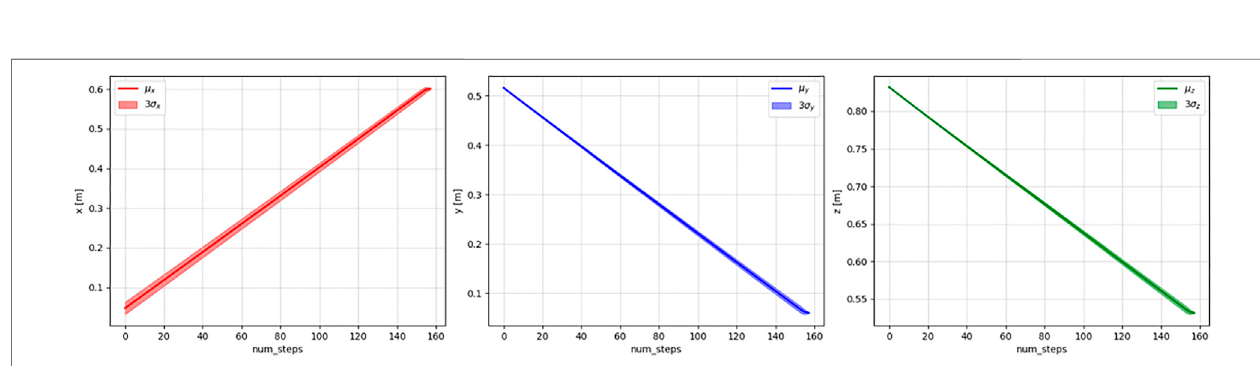
FIGURE 7 | Means and three standard deviations of the x (left), y (middle), and z (right) values of the demonstrated trajectories.